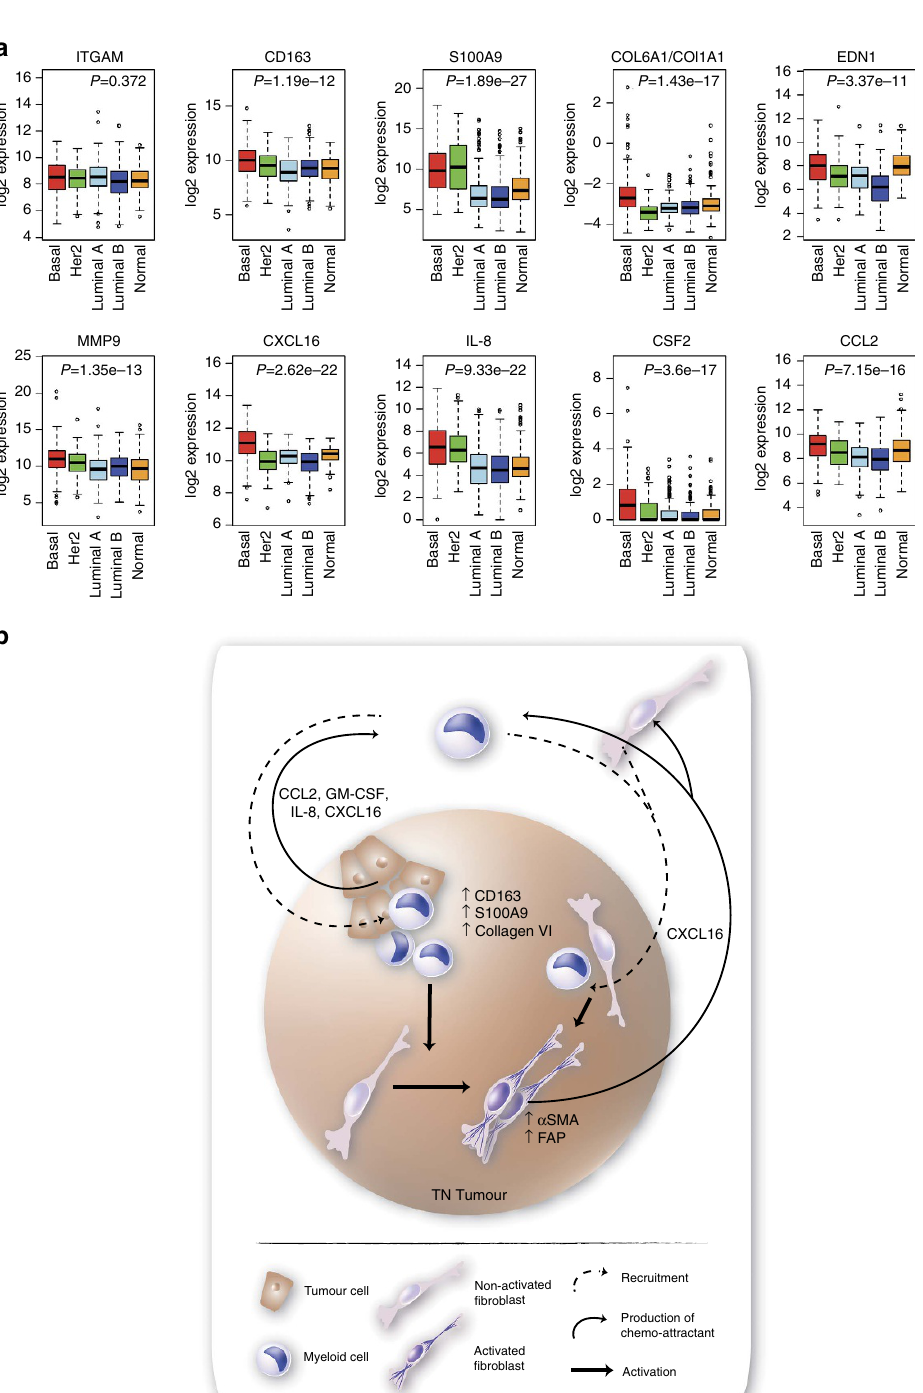
Figure 7 | Gene expression profile in human breast cancers. Human basal breast cancers have an immunosuppressive gene expression profile. ( a ) Box plots showing log2 gene expression levels of indicated genes in molecular breast cancer subtypes, using TCGA breast cancer RNAseq data. P values were calculated using a t -test comparing levels between basal-like tumours and luminal A tumours. The middle line demonstrates the median, the box illustrates the interquartile range, and the whiskers indicate the most extreme data point that is not 4 1.5 (cid:3) the interquartile range away from the box. Data points beyond these values are individually shown. ( b ) Schematic to model the effects exerted by myeloid cells on stroma formation in TN breast tumours. Myeloid cells are recruited to TN breast tumours by proteins including CCL2, GM-CSF, IL-8, S100A9 and CXCL16, where they are induced to express CD163 and the immunosuppressive factors S100A9 and collagen VI. Furthermore, in a TN environment, the myeloid cells activate CAFs and induce expression of CXCL16 by the fibroblasts, which, in turn, can recruit more myeloid cells and fibroblasts. The activated stroma in combination with the presence of anti-inflammatory myeloid cells, will render the TN tumours a more aggressive